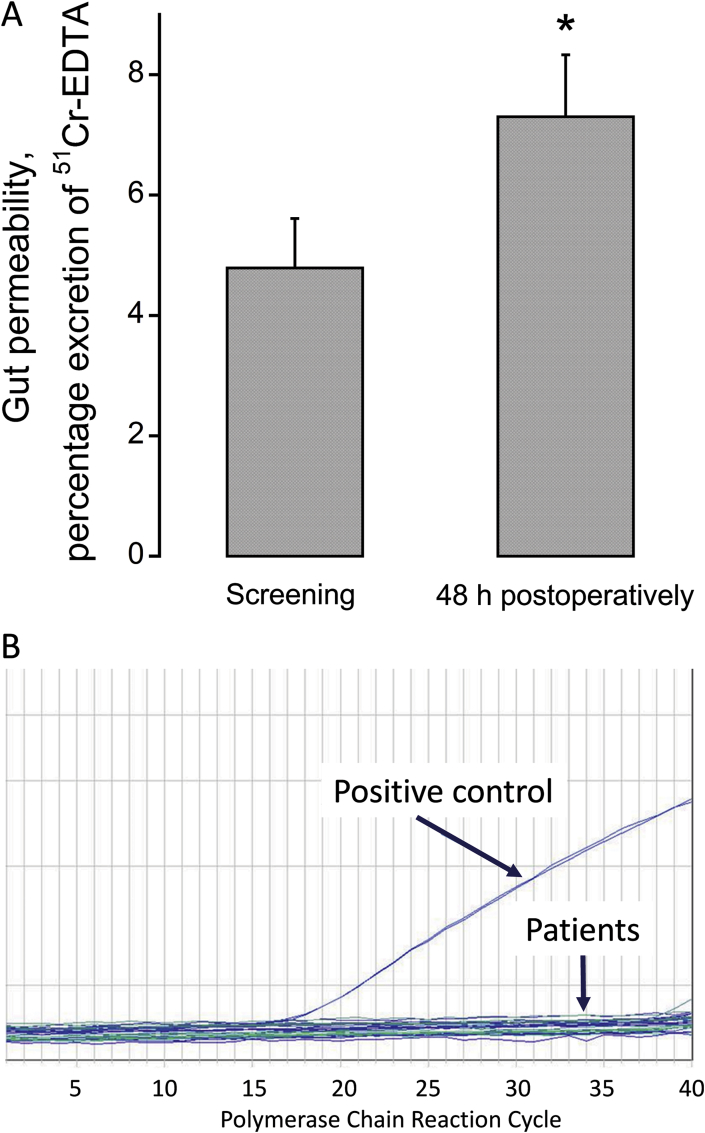
A. Gut permeability in participants undergoing major abdominal surgery preoperatively and 48 h postoperatively (n = 15), *P < 0.05. B. The presence of DNA representative of Gram positive bacteria in circulating blood in participants 48 h postoperatively (n = 15). The positive control comprised of DNA isolated from the Gram positive wild-type strain SG38 of Bacillus subtilis, which is found in the gastrointestinal tract of humans.